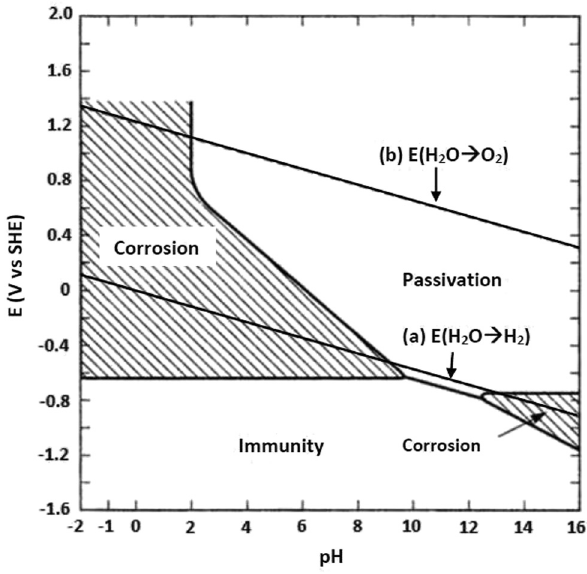
Figure 4: Pourbaix diagram for steel showing the zone of immunity, corrosion, and passivation. Equation for ( a ) : E ( water → H 2 ) = 0.000 – 0.0591 pH. Equation for ( b ) E ( water → O pH [ 26 ]